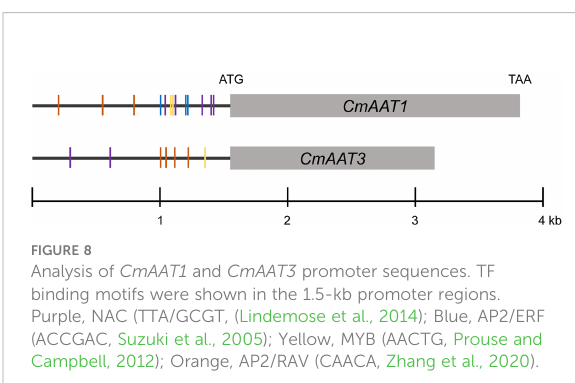
FIGURE 8 Analysis of CmAAT1 and CmAAT3 promoter sequences. TF binding motifs were shown in the 1.5-kb promoter regions. Purple, NAC (TTA/GCGT, (Lindemose et al., 2014); Blue, AP2/ERF (ACCGAC, Suzuki et al., 2005); Yellow, MYB (AACTG, Prouse and Campbell, 2012); Orange, AP2/RAV (CAACA, Zhang et al.,